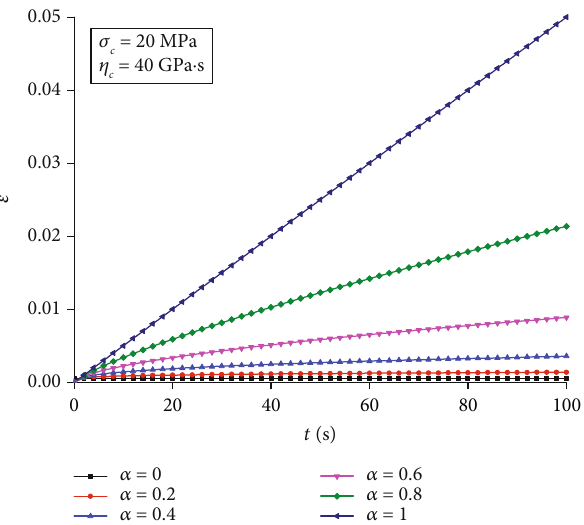
Figure 3: E ff ect of di ff erent orders of α on creep properties.